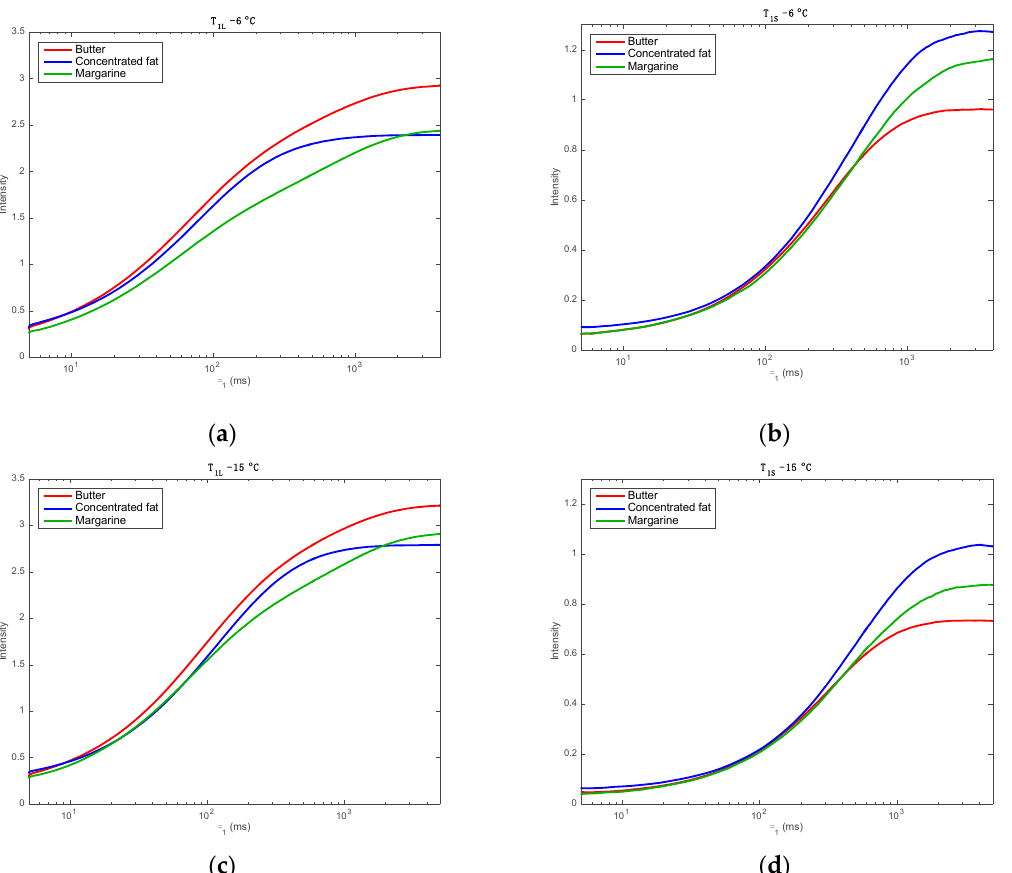
Figure 2. Mean signal of each class of products. ( a , c ): T 1L , ( b , d ): T 1S , ( a , b ): T=6 °C, ( c , d ): T=15 °C. Vertical scale of ( b , d ) is different from that of ( a , c ). Horizontal scale is logarithmic.